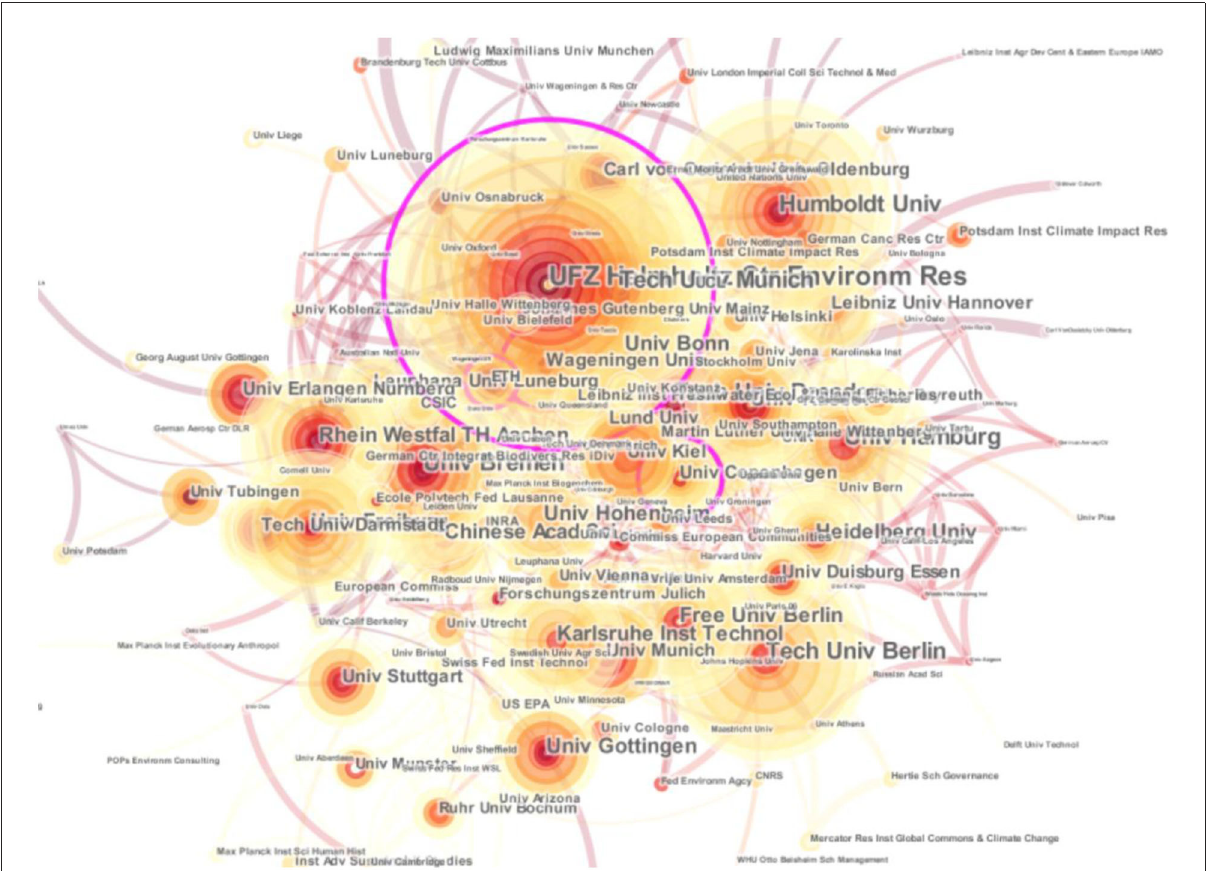
FIGURE3 Environmental research cooperation network of German universities and research institutions. Source: This map was drawn by the author through